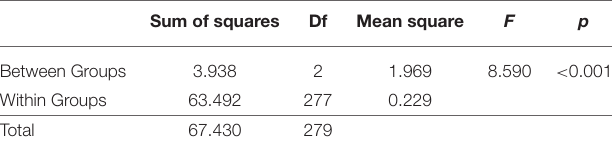
TABLE 6 | ANOVA for self-regulated learning